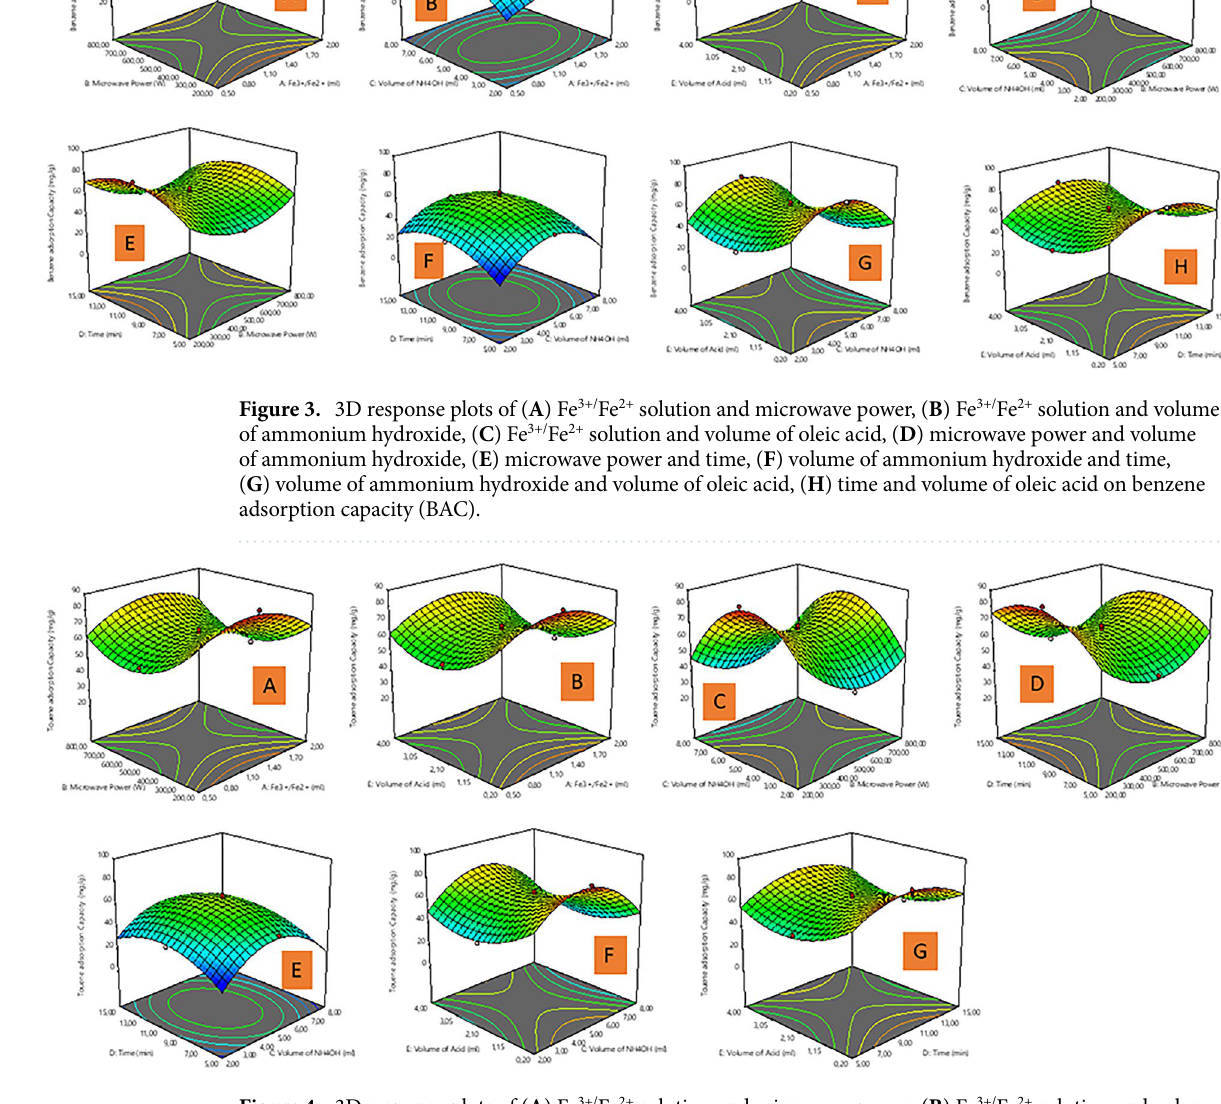
Figure 4. 3D response plots of ( A ) Fe 3+/ Fe 2+ solution and microwave power, ( B ) Fe 3+/ Fe 2+ solution and volume of oleic acid, ( C ) microwave power and volume of ammonium hydroxide, ( D ) microwave power and time, ( E ) volume of ammonium hydroxide and time, ( F ) volume of ammonium hydroxide and volume of oleic acid, ( G ) time and volume of oleic acid on toluene adsorption capacity